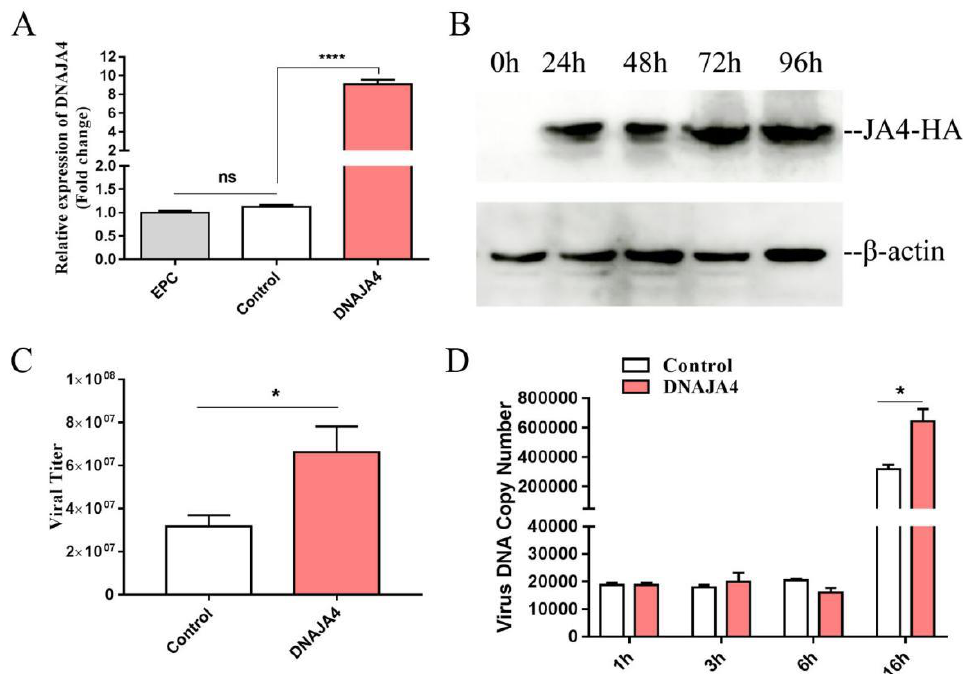
Figure 4. Effect of overexpression of DNAJA4 on CGSIV replication: ( A ) transcriptional level detection 24h after overexpression of pcDNA3.1-DNAJA4-HA plasmid; ( B ) detection of protein level of plasmid overexpressing pcDNA3.1-DNAJA4-HA; ( C ) effect of overexpression of DNAJA4 for 48h on viral titer; and ( D ) effect of overexpression of DNAJA4 on the copy number of viral genomic DNA. The results were expressed as mean ± SD, ( n = 3; * p < 0.05; **** p < 0.0001)